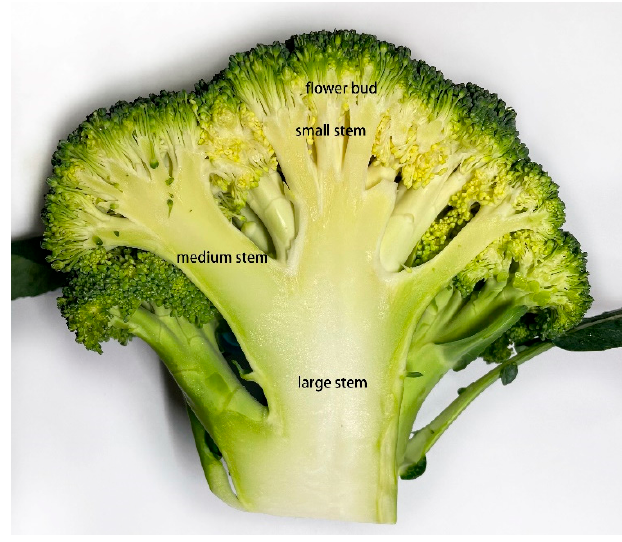
Figure 1. Example of a broccoli block considered in this study.